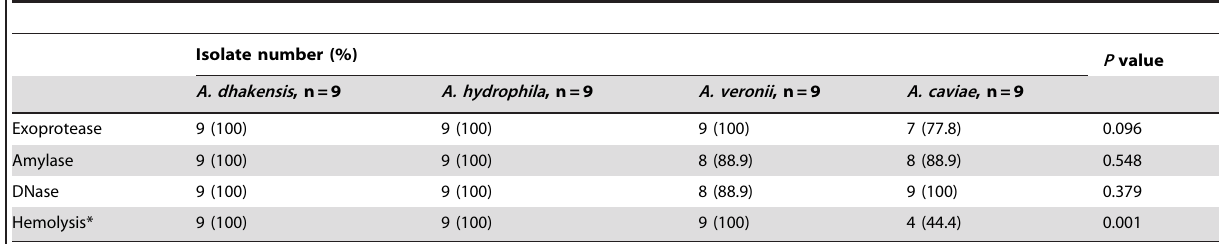
Table 2. The results of agar plate assays for exoprotease, amylase, DNase, and hemolytic activity of isolates of four Aeromonas species: A. dhakensis , A. hydrophila , A. veronii and A. caviae .